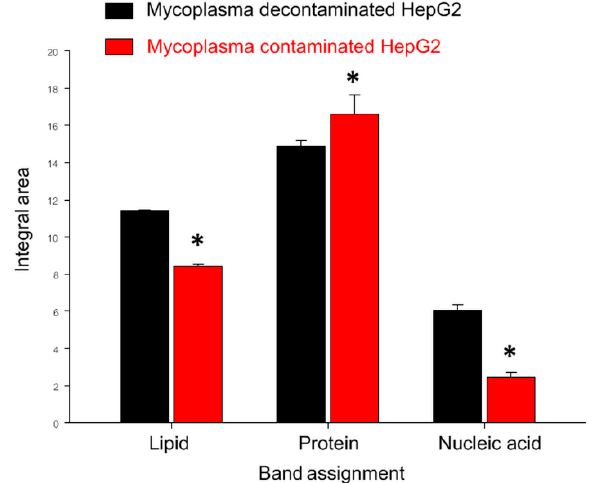
Figure 5. Histogram representing the mean integral areas of the respective lipid ( 3000 – 2800 cm − 1 ) , protein ( 1700 – 1450 cm − 1 ) , and nucleic acid ( 1280 – 900 cm − 1 ) regions of mycoplasma-decontaminated and -contaminated cells . Data are presented as mean ± SD ( n = 3 ). * , p < 0 . 05, paired t - test., n contaminated = 58 and n decontaminated = 67 .